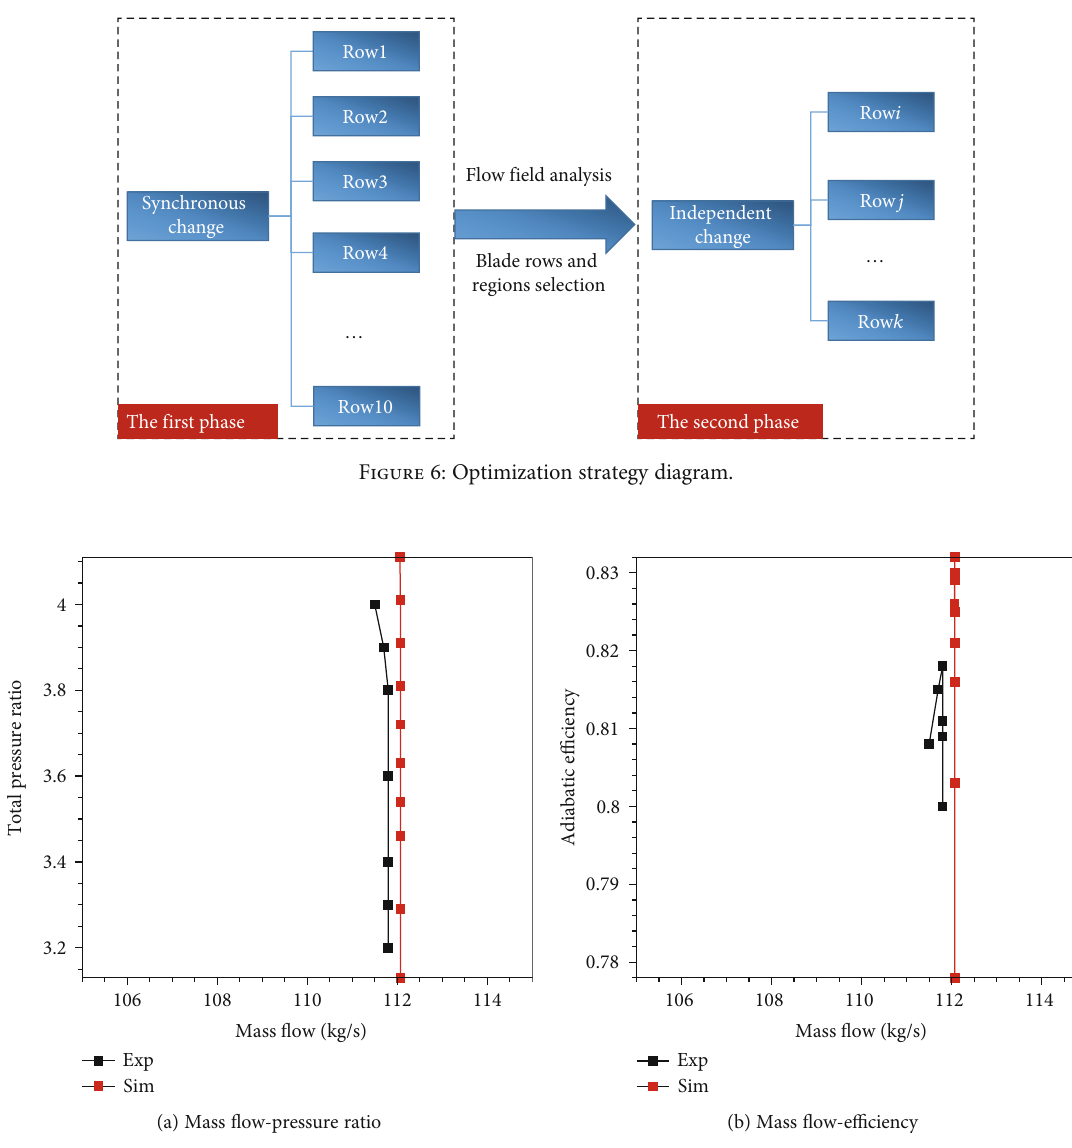
Figure 7: Comparison of the experimental and calculated values of the compressor performance at the design